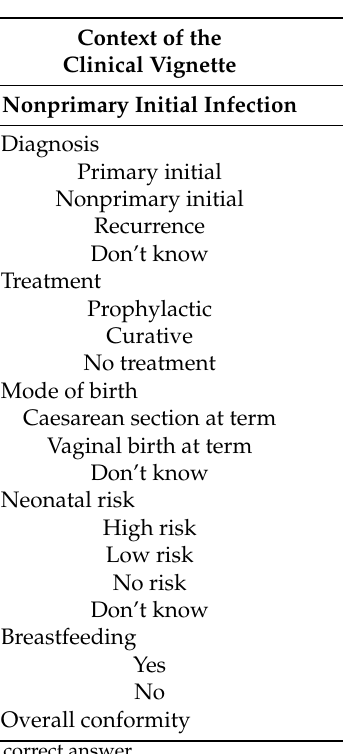
Table 3. Results of clinical scenarios of nonprimary initial